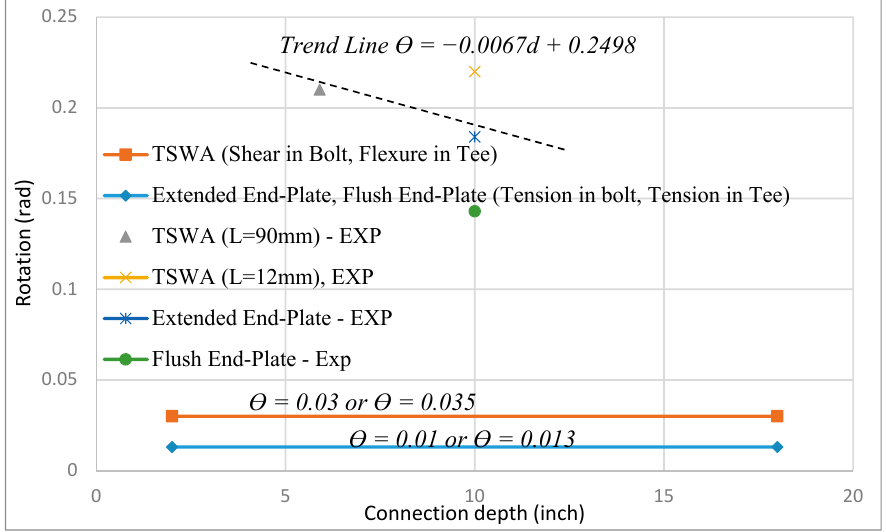
Figure 14. Maximum rotation capacities versus connection depth for semi-rigid connections.